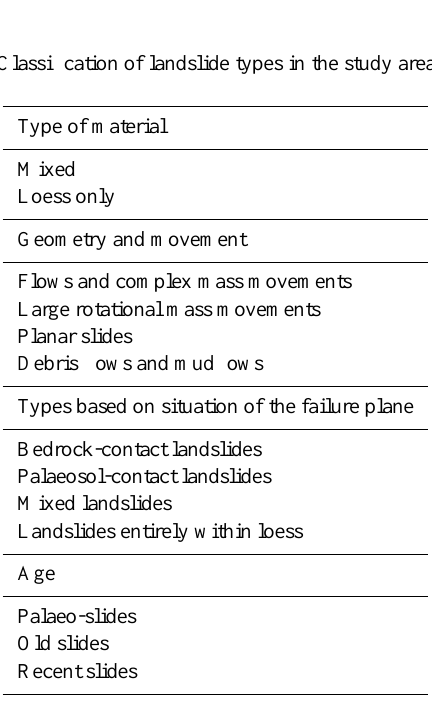
Fig. 4. View of the Zhuyuan and Lijiaquan landslides in a Quickbird